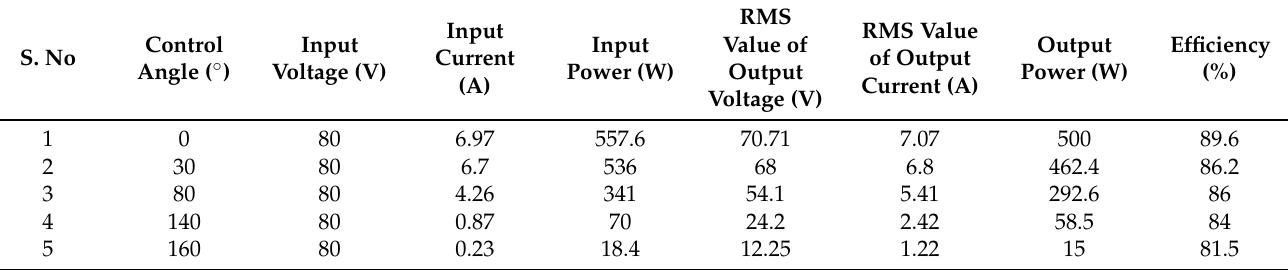
Figure 10. Asymmetrical duty control. ( a ) Switching pulses for α = 30 ◦ . ( b ) Output voltage and current waveforms for α = 30 ◦ . ( c ) Output voltage and current waveforms for α = 140 ◦ . ( d ) Switch voltage and current waveforms for α = 30 ◦ . ( e ) Harmonics spectrum for α = 140 ◦ . ( f ) Temperature variation. ( g ) Heat rate for various control angles. ( h ) FLIR thermal image for various control angles at t = 5 min. Table 5. Efficiency of asymmetrical duty